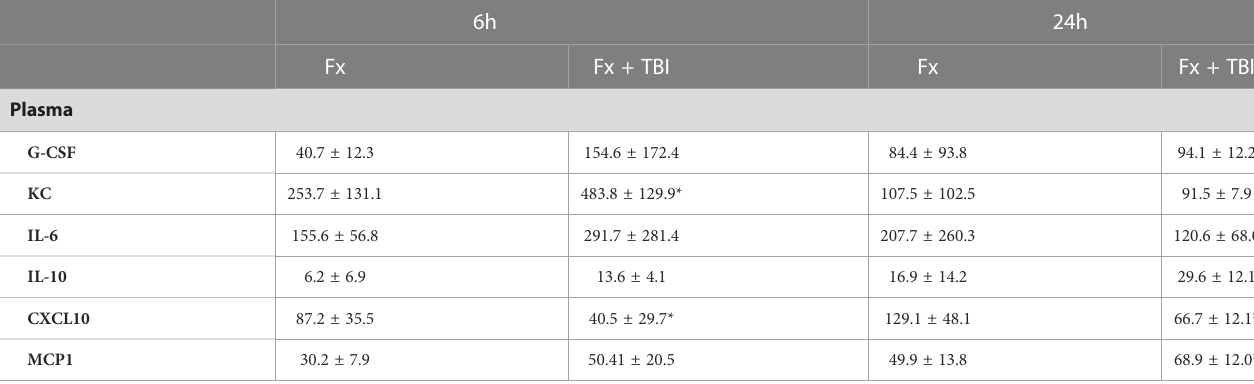
TABLE 1 In fl ammatory mediator levels in the